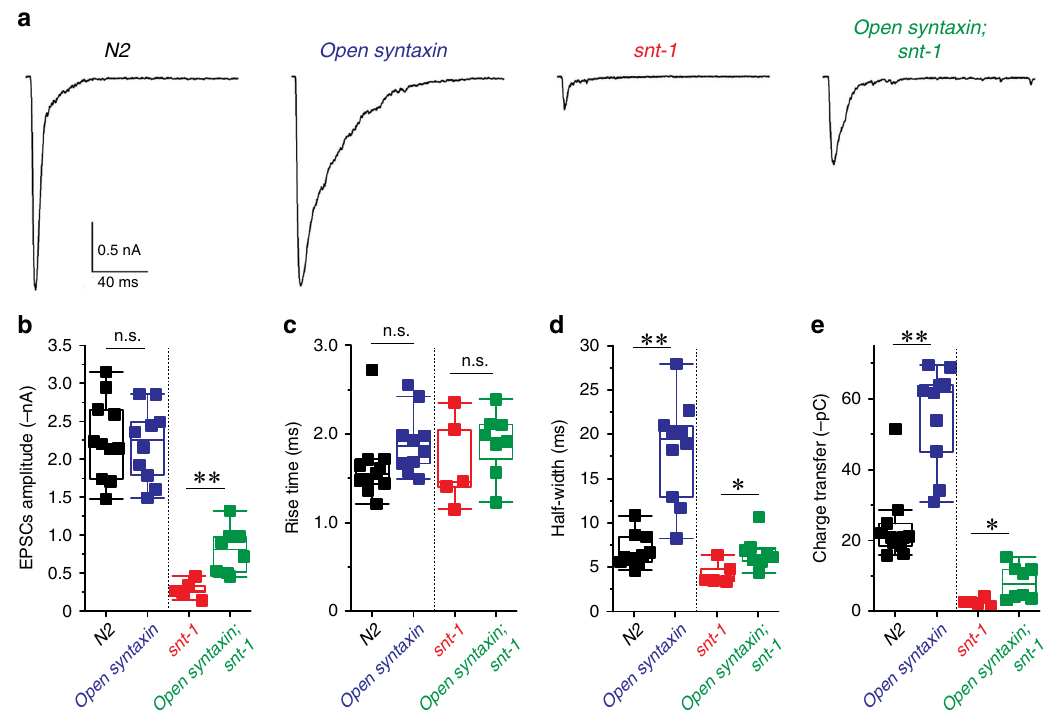
Fig. 3 The knock-in open syntaxin mutation enhances evoked neurotransmitter release compared with the wild-type and partially restores the defects of evoked release of snt-1 mutants. a Representative EPSCs traces recorded from wild-type N2, open syntaxin, snt-1 , and open syntaxin; snt-1 worms in the zxIs6 transgenic background with 10 ms blue light illumination (3.75 mW/mm 2 ). Muscle cells were recorded with a holding potential of − 60 mV. b – e Box- and-whisker plots overlaid with the corresponding data points (squares) of EPSCs amplitude ( b ), rise time (10 – 90%) ( c ), half-width ( d ), and total charge transfer ( e ) of wild-type N2 ( n = 11), open syntaxin ( n = 10), snt-1 ( n = 5), and open syntaxin; snt-1 ( n = 8) worms, respectively. Two-sample two-sided t -test was performed for the comparison between WT N2 vs. open syntaxin and snt-1 vs. open syntaxin; snt-1 in each parameter. For amplitude ( b ), N2 vs. open syntaxin: n.s. p = 0.75, snt-1 vs. open syntaxin; snt-1 : ** p = 0.00. For rise time ( c ), N2 vs. open syntaxin : n.s. p = 0.10; snt-1 vs. open syntaxin; snt-1 : n.s. p = 0.39. For half-width ( d ), N2 vs. open syntaxin : ** p = 0.00, snt-1 vs. open syntaxin; snt-1 : * p = 0.03. For total charge transfer ( e ), N2 vs. open syntaxin : ** p = 0.00; snt-1 vs. open syntaxin; snt-1 : * p = 0.03. Box-and-whisker plots represent the median (central line), 25th – 75th percentile (bounds of the box), and 5th – 95th percentile